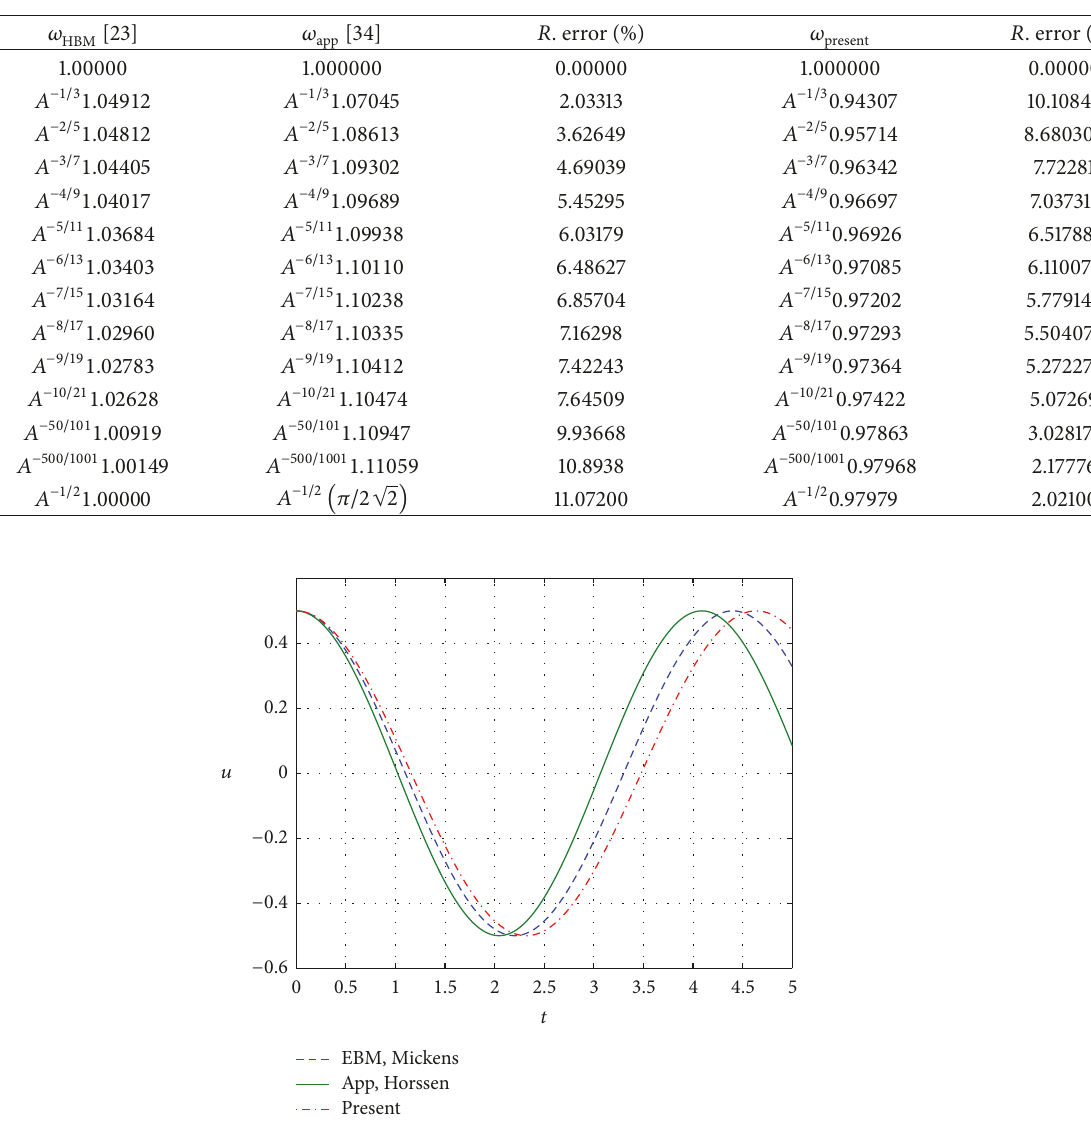
Figure13: Comparisonof timehistorydiagram ofdisplacement between thepresent,HBM[23], andApp [34]solutionswith 𝑛 = 10 , Example